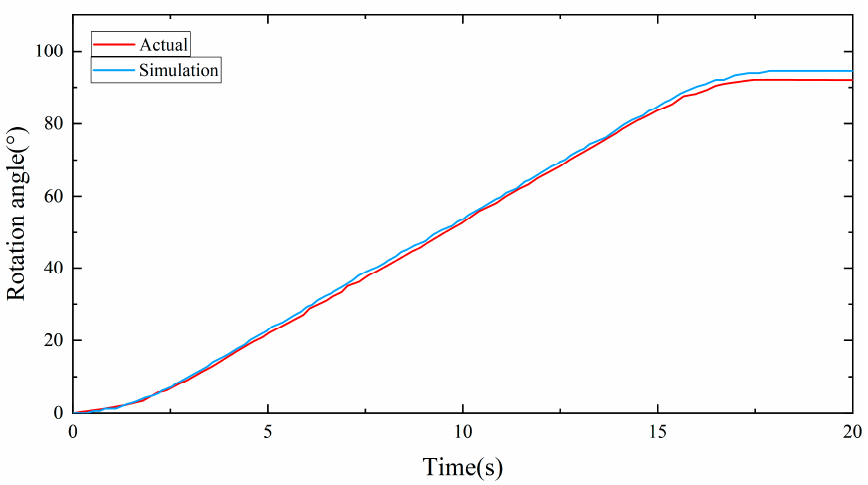
Figure 12. Comparison of the rotation angle.